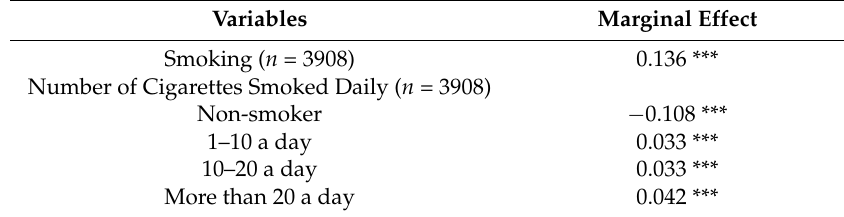
Table 5. Marginal effects of unemployment rate on smoking behavior of employed individuals.